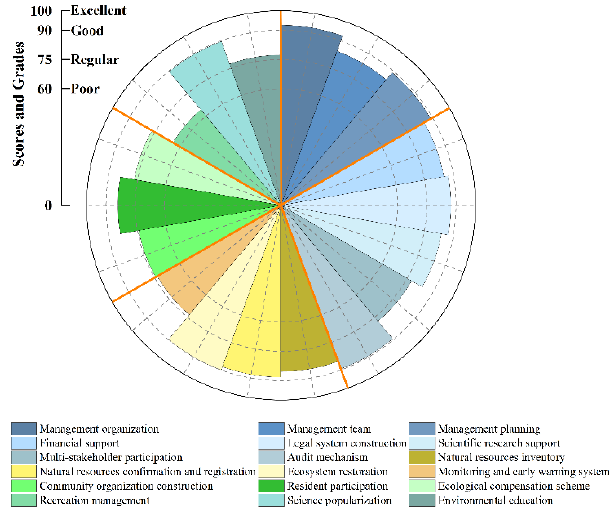
Figure 3. Grades of single management capacity of TNP in 2021.